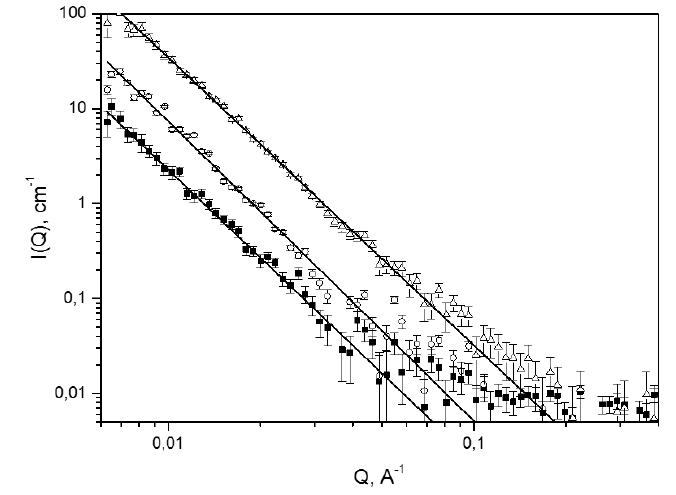
Figure 4. Small-angle neutron scattering from Vit105: as-cast ( (cid:4) ); after HPT n = 10 ( n = 10 ( (cid:52)